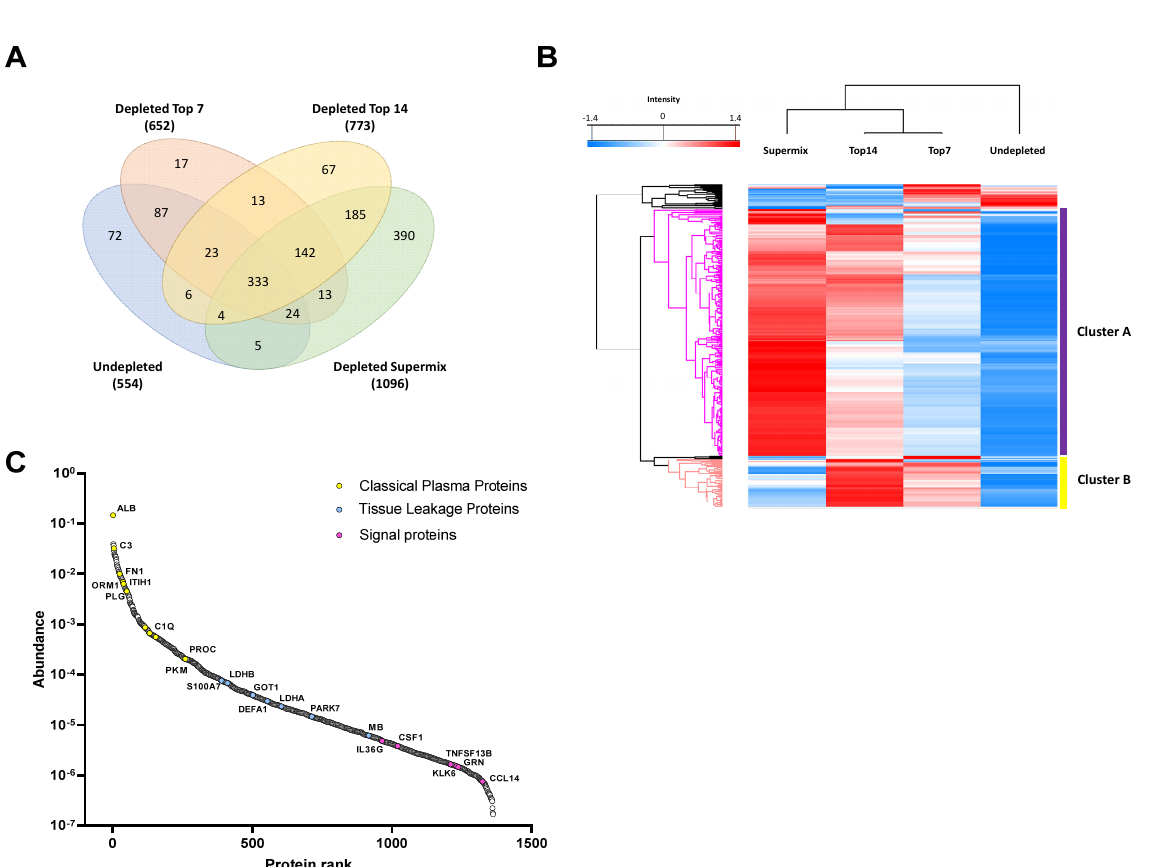
Figure 1. Descriptive results of the proteomic analysis of immunodepleted plasma samples. ( A ) Comparative analysis of the number of proteins identified by each approach. ( B ) A hierarchical clustering heat map of the proteins identified as common among the 4 groups of samples studied. The gradient from blue to red represents the Z-score scale ranging from − 1.4 to 1.4. ( C ) Protein abundance distribution curve. Classical plasma proteins, tissue leakage, and signaling proteins are highlighted. Tissue leakage proteins were defined as plasma proteins that are not secreted into the blood stream, classified as intracellular proteins (by available information) according to The Human Protein Atlas database (https://www.proteinatlas.org/search/protein_class:Plasma+proteins, and https://www.proteinatlas.org/humanproteome/blood+protein/secreted+to+blood, accessed on: 5 March 2020) [45–47].